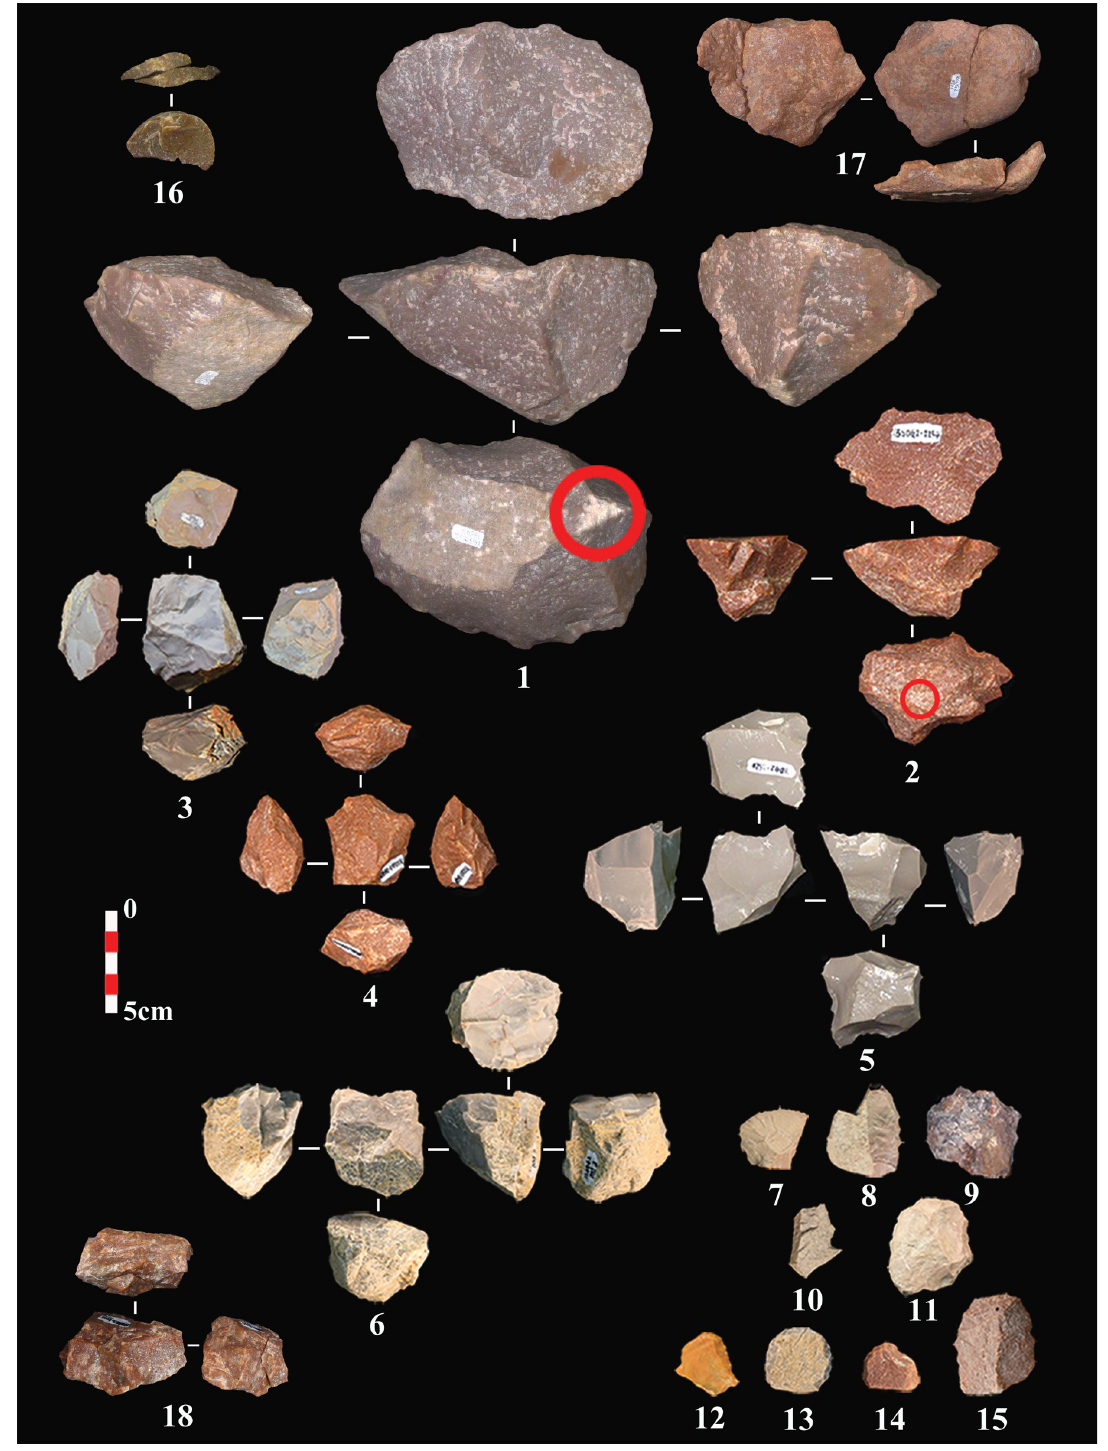
Fig 6. A few examples of cores and tools at SDG2. Single-platform cores (anvil-assisted cores?) (1–2); Discoid-like/alternating flaking cores (3–4); Multi-platform cores (5–6); Side scrapers (7–8); Denticulate (9); Notch (10); Splintered piece (11); End scrapers (12–15); Refits